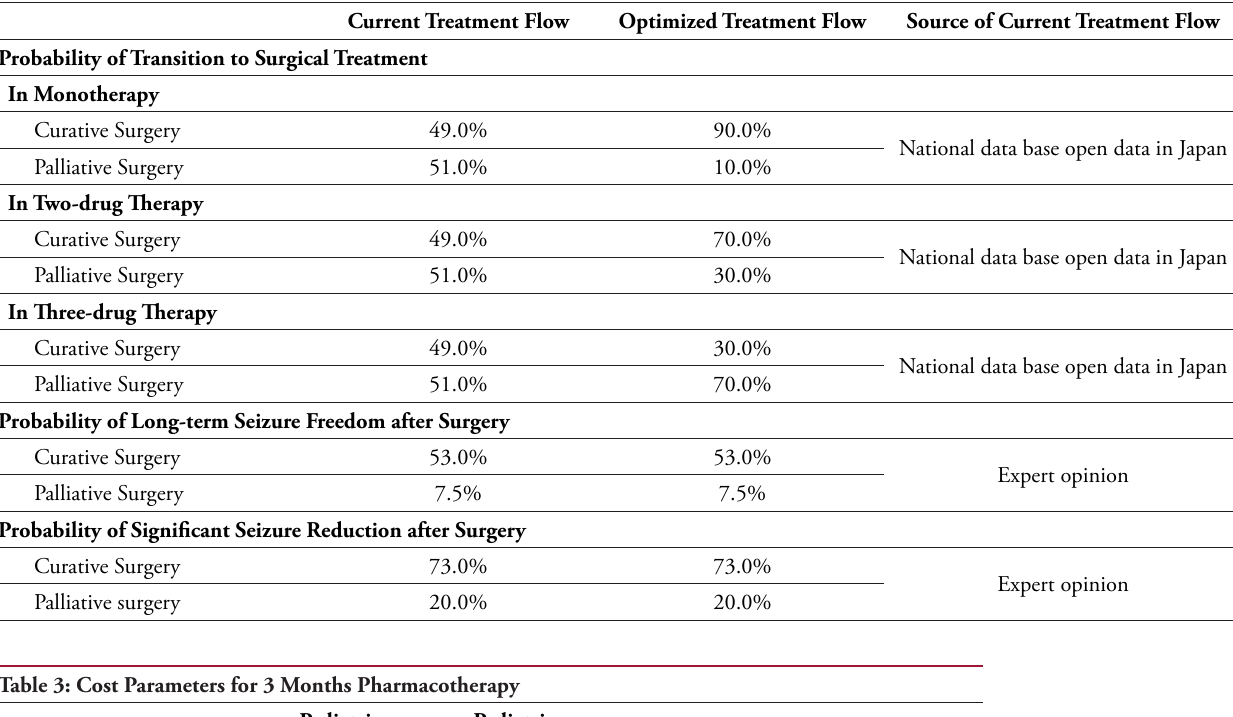
Table 2: Clinical Parameters in Surgery